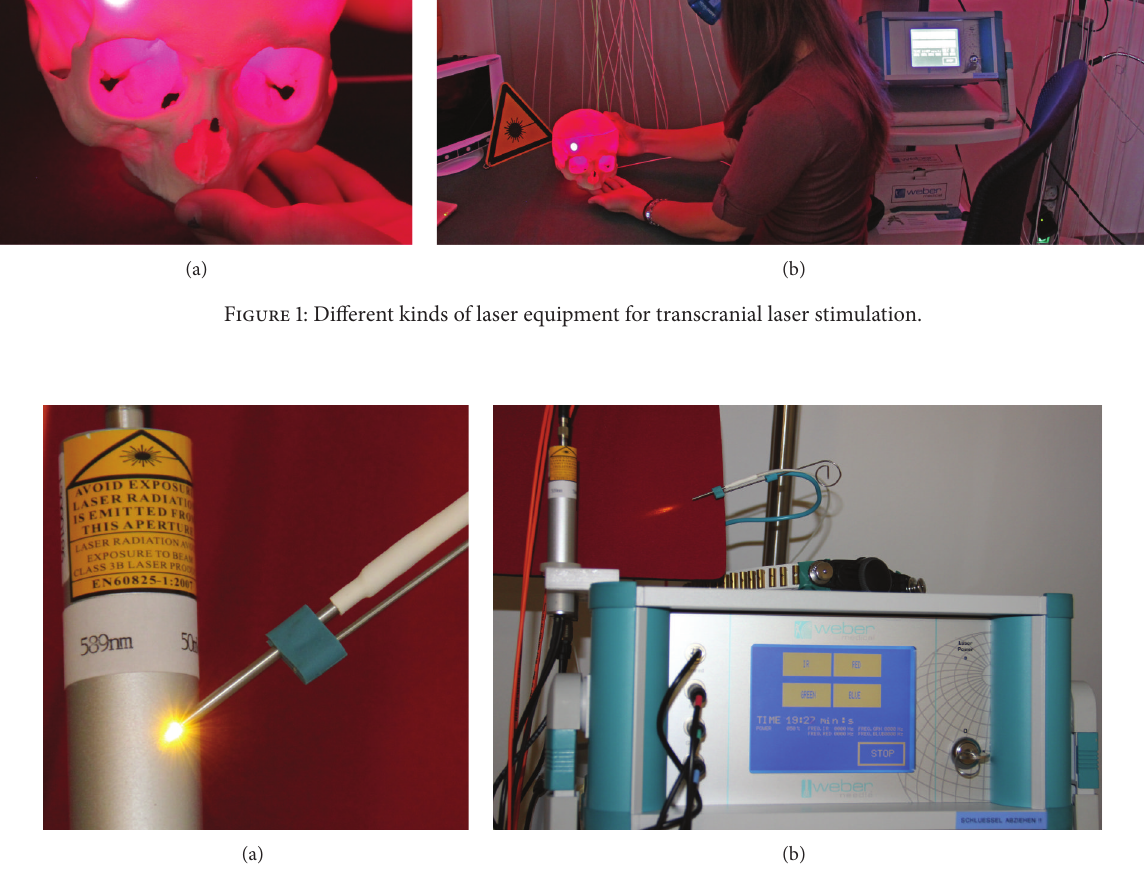
Figure 2: First yellow laser (589nm, 50mW) for future medical applications at the Medical University of